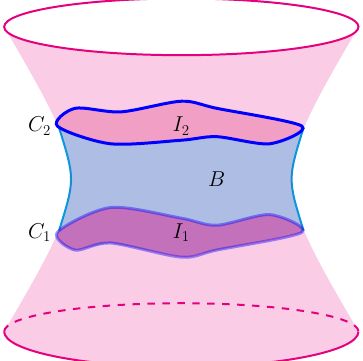
Figure 3 . I 1 ; I 2 depict constant de Sitter time ( (cid:28) = cons :t ) and blue-shaded region B shows constant (cid:26) slice of the Mink d between the two constant (cid:28) regions. C 1 ; C 2 are boundaries of these constant time slices; these are two S d (cid:0) 2 spheres corresponding to codimension 2 (cid:26); (cid:28) -constant surfaces in the Mink d